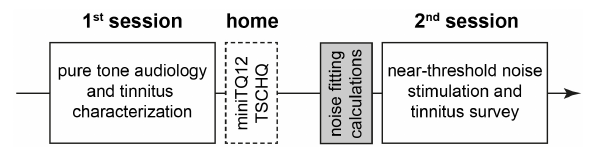
FIGURE 1 | Overview of the temporal sequence of the study. White solid line: interaction with patient during the sessions. White broken line: work of patient at home alone. Gray: preparation of acoustic stimulation by investigator